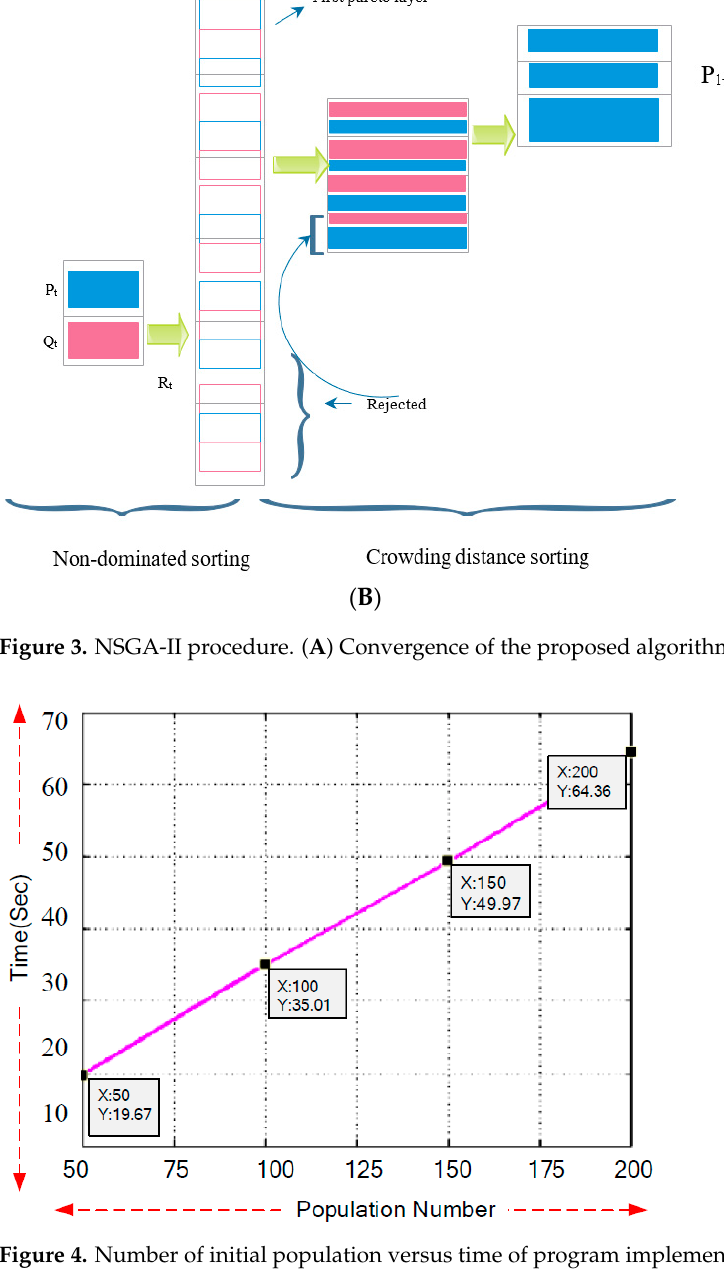
Table 1. The main parameters of the proposed method and program execution time for the studied